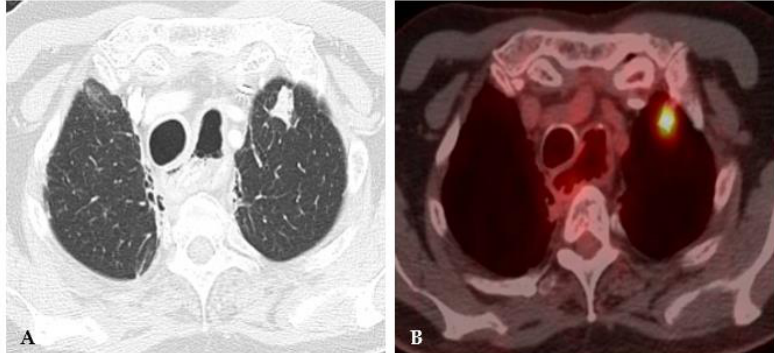
Figure 4. Acute histoplasmosis infection. ( A ) Axial CT image depicts a left upper lobe nodule. ( B ) FDG PET/CT shows avid uptake in the pulmonary infection.